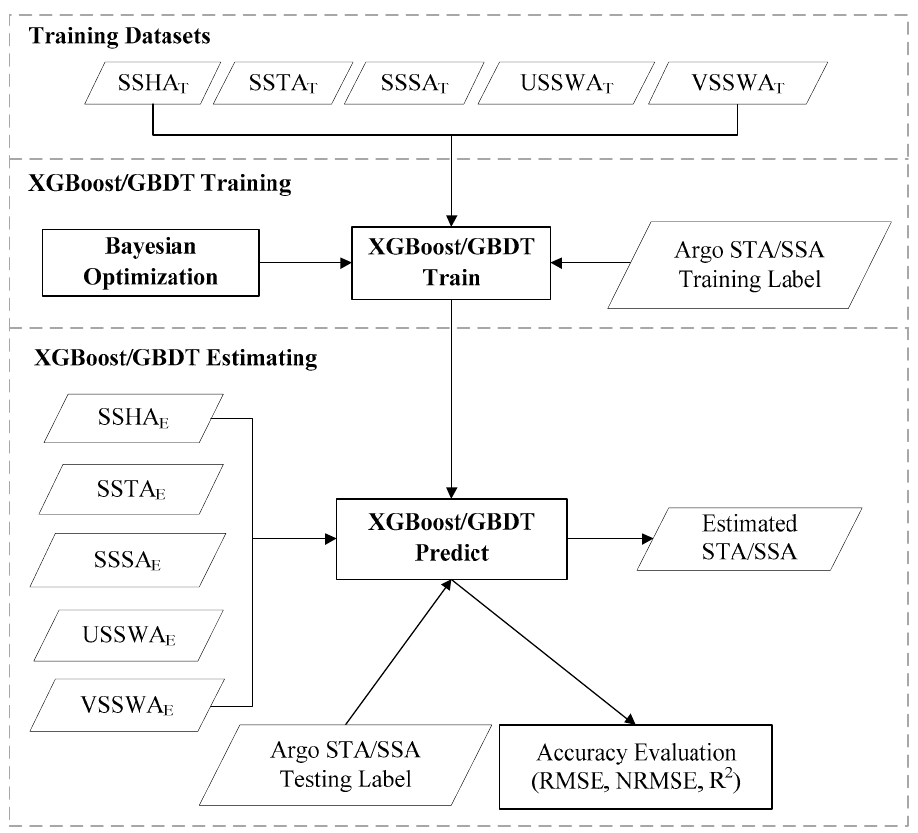
Figure 1. Flowchart for the STA and SSA inversion (at different levels) in the global ocean using the XGBoost/GBDT regression approach.